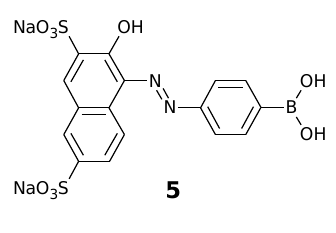
Figure 4. Chemical structure of dye 5 .